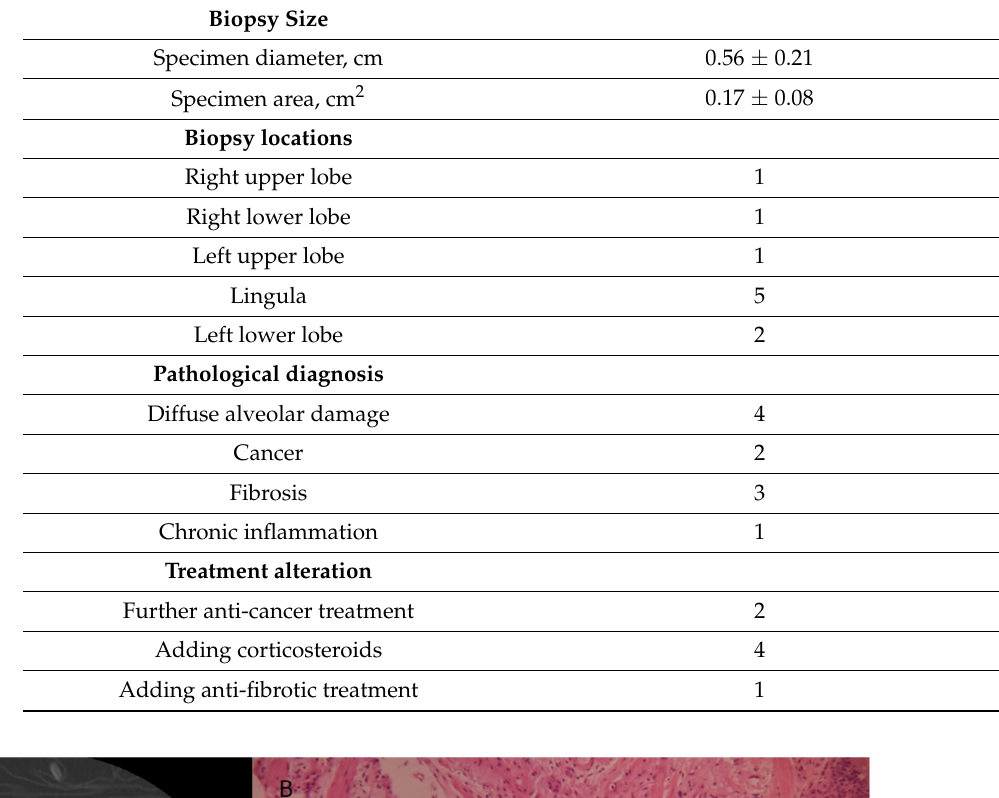
Table 2. Histopathological diagnoses of patients receiving cryobiopsy.